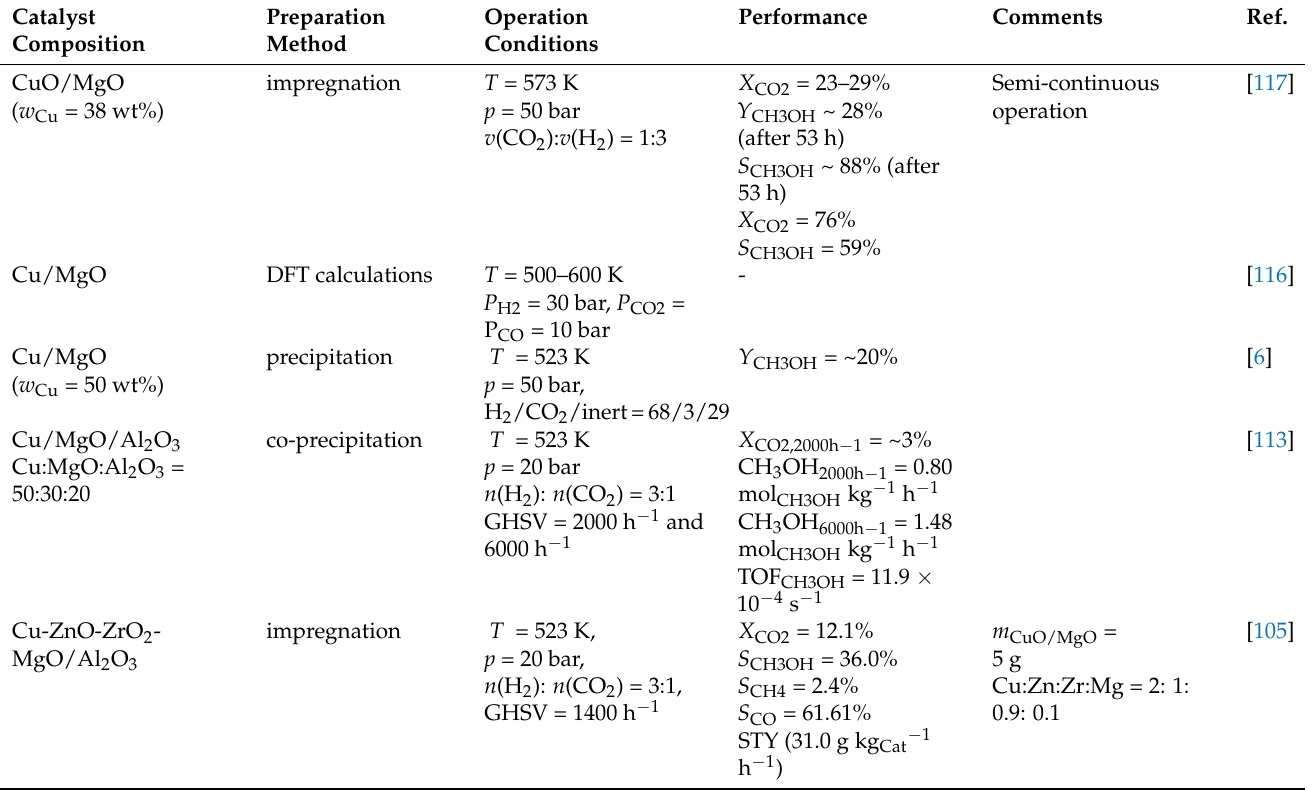
Table 2. Experimental studies using Cu-based catalysts on MgO carrier material for CO 2 hydrogena- tion to